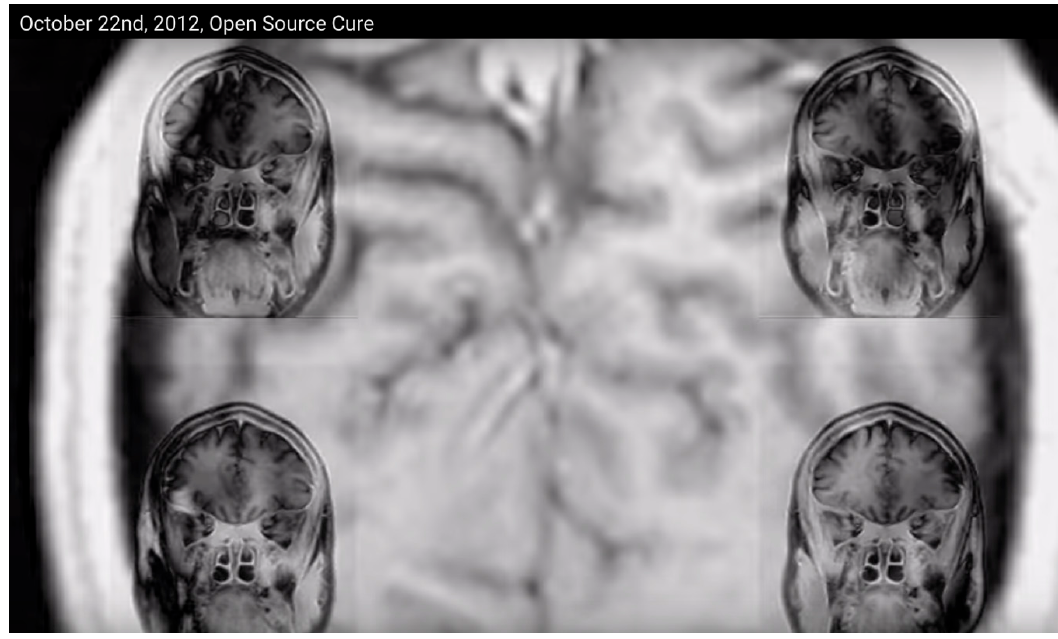
Figure 2. Iaconesi’s brain scan screenshot from the Webpage, https://www.youtube.com/watch?v=C1C5D6pl6UM. Courtesy of the author.